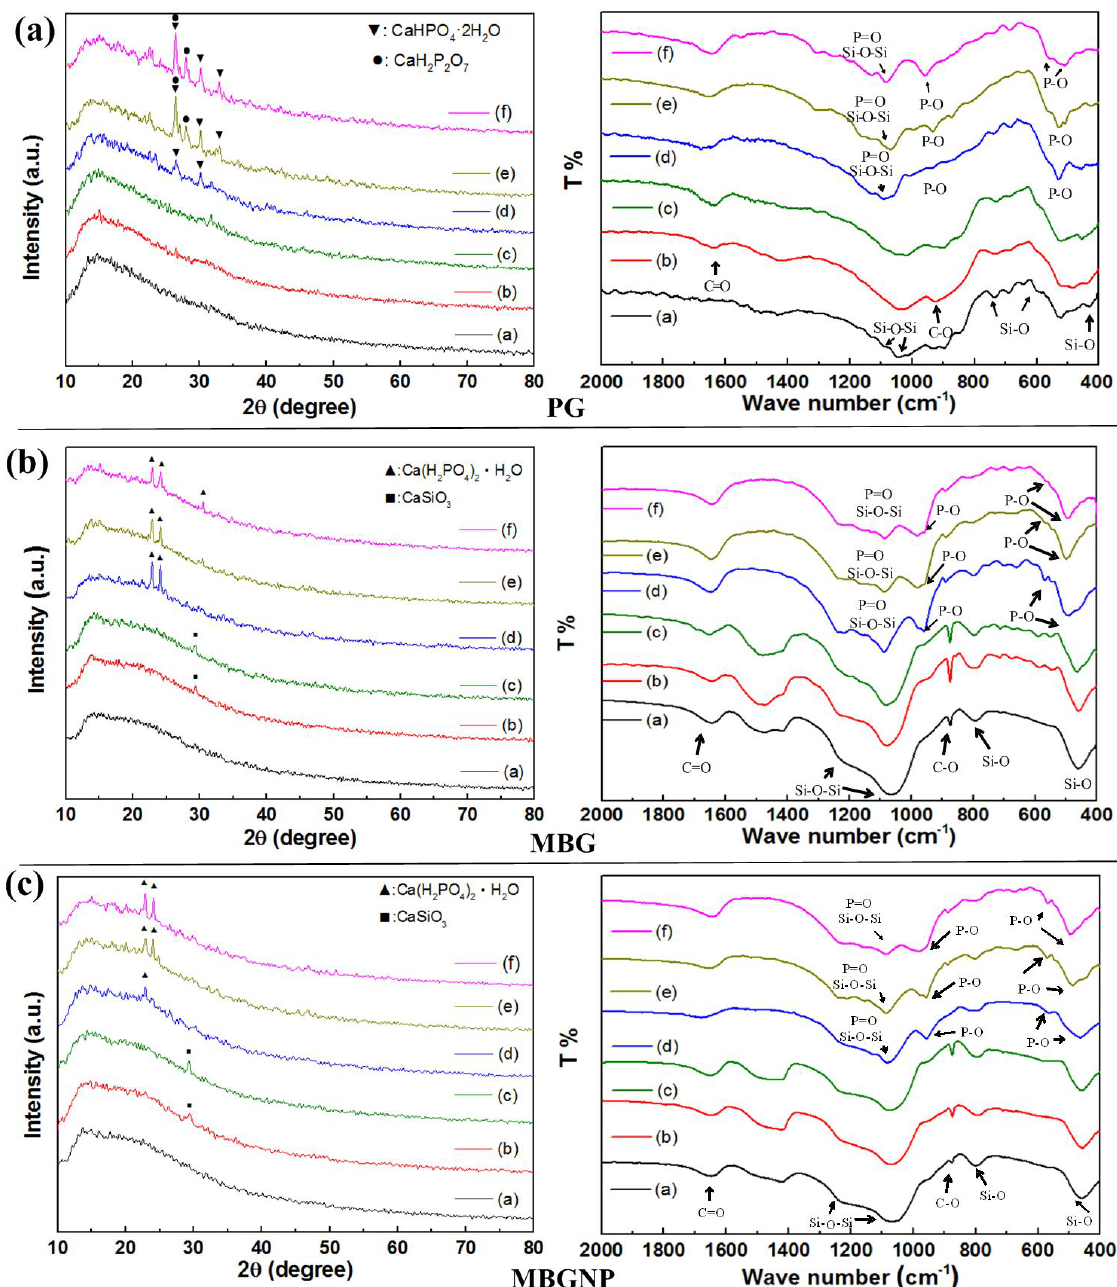
Figure 1. The X-ray diffractometer (XRD) pattern and Fourier transform infrared spectroscopy (FTIR) spectra of ( a ) PerioGlas (PG), ( b ) mesoporous bioactive glass (MBG), and ( c ) MBG without phosphorous (MBGNP) mixed with varied luting solutions for 10 min. The condition labels in figure are: ( a ) PG; ( b ) PG/W; ( c ) PG/PBS; ( d ) PG/20PA; ( e ) PG/30PA; ( f ) PG/40PA (the symbol of PG/ indicate the PG reacted with varied solutions: W: de-ionized water; PBS: phosphate buffered saline; 20, 30 and 40PA: 20, 30 and 40 wt % PA